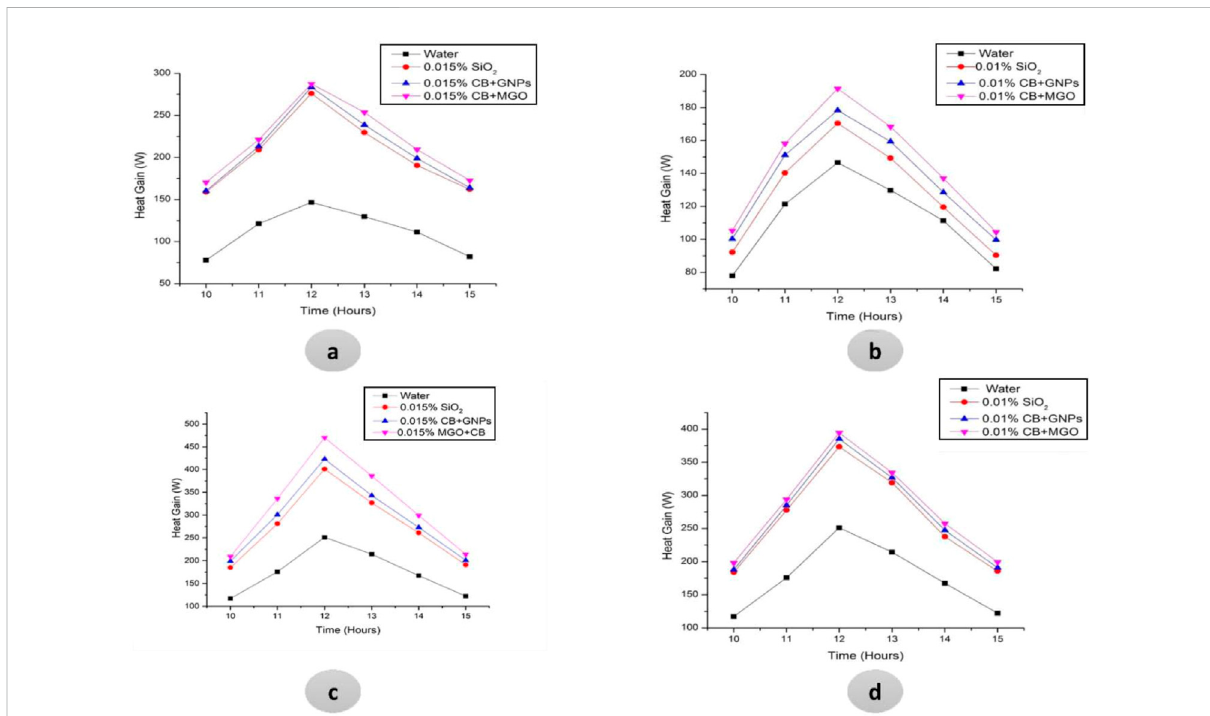
FIGURE 11 Solar heat gain received by CPCs at different fl ow rates for different concentrations of NFs and hybrid NFs for Taxila climate. (A) 0.010 kg/sand 0.015 wt% fl ow rate and concentration of NFs and hybrid NFs, respectively. (B) 0.01 kg/s fl ow rate and 0.010 wt% concentration of NFs and